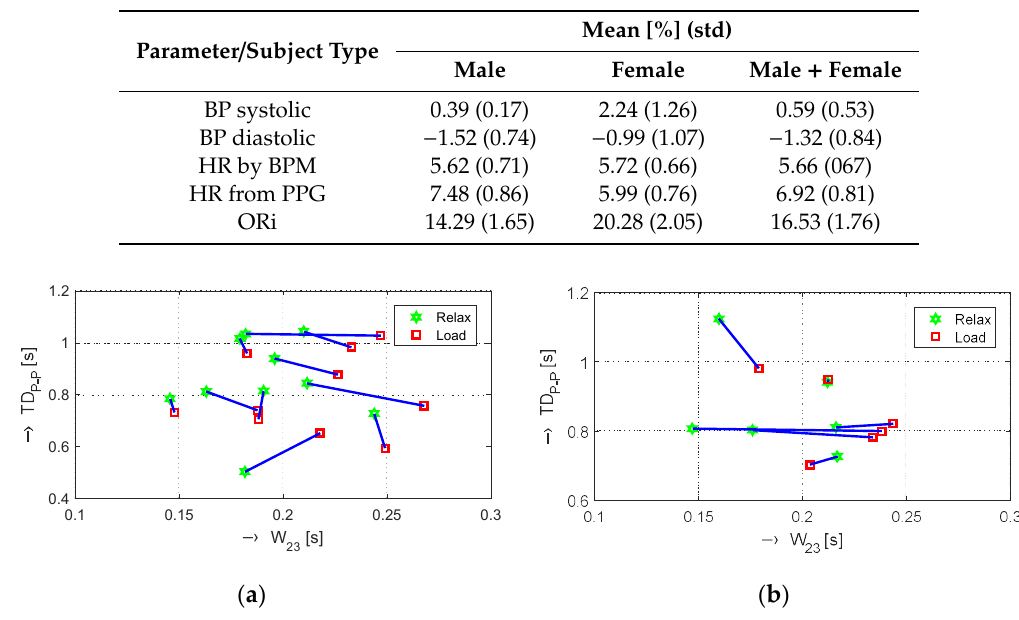
Table 2. Mean (std in parentheses) values of relative di ff erences in [%] of blood pressure (BP), heart rate (HR), and Oliva–Roztocil index (ORi) parameters between Relax and Load phases obtained from auxiliary and preliminary experiments. BPM, BP monitor.